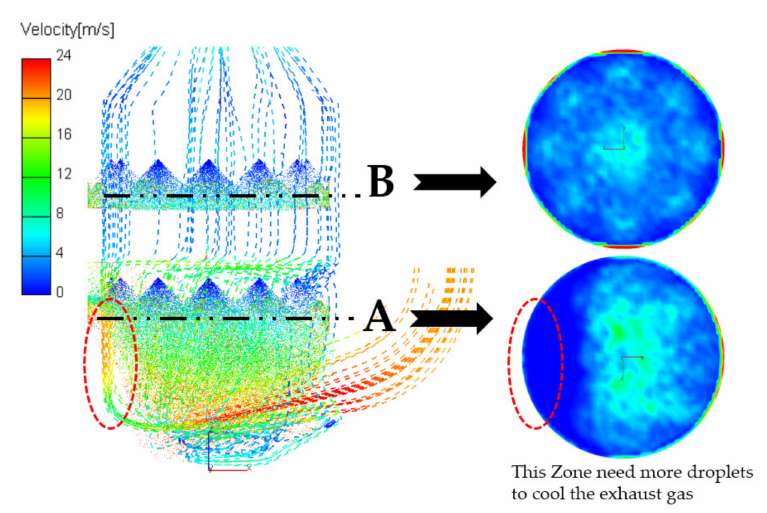
Figure 12. Distribution of the droplets inside the scrubber (Z A = 2.2 m, Z B = 3.92